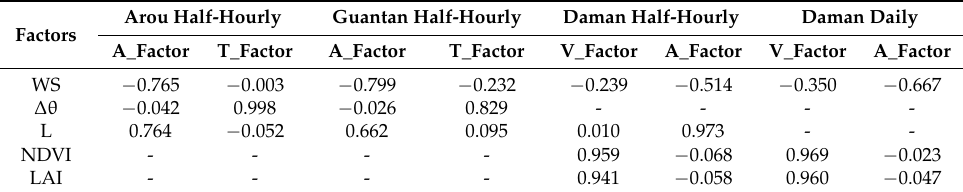
Table 3. Rotated component matrix in factor analysis.